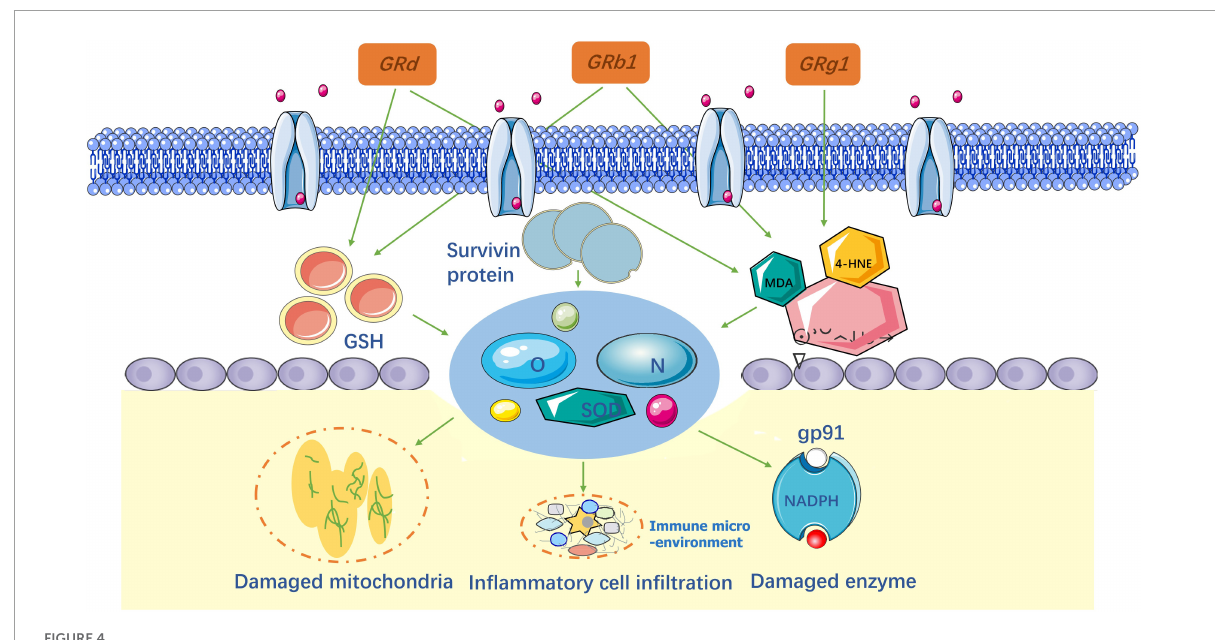
FIGURE4 Anti-oxidative stress and lipid peroxidation mechanism of ginsenosides.